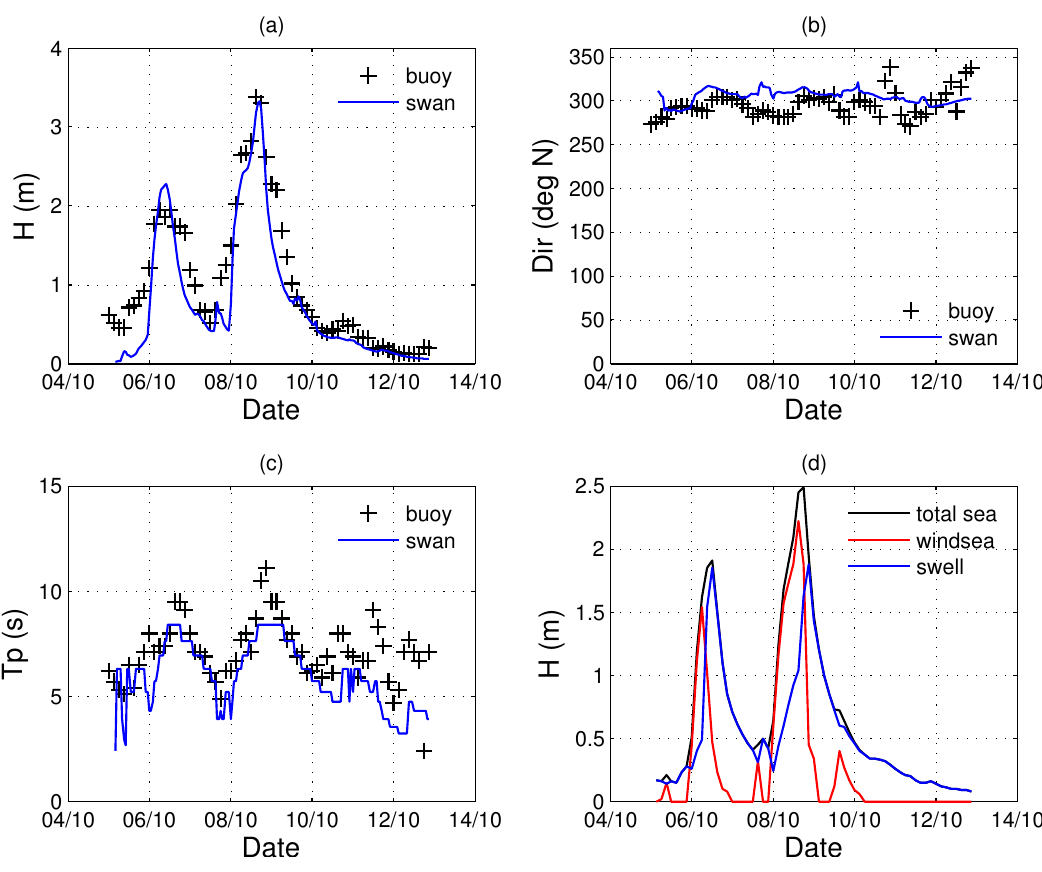
Fig. 16. Tropea, 5–13 October 2003 storm: (a) comparison of H s SWAN vs. buoy records, (b) comparison of Dir SWAN vs. buoy records, (c) comparison of T p SWAN vs. buoy records, (d) WAM series of wind sea, swell and total H s out of the regional Fig. 16. Tropea, 5-13 October 2003 storm: (a) comparison of H (c) comparison of Dir SWAN vs. buoy records. (d) WAM series of wind sea, swell and total H